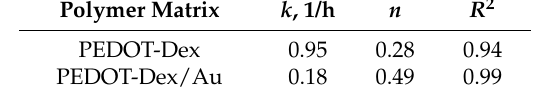
Figure 4. Dex release from Dex-doped PEDOT and PEDOT composite substrates. ( A ) Drug elution profiles of spontaneous Dex release from PEDOT-Dex and PEDOT-Dex/Au functionalized electrodes. Dots are the experimental values and lines represent the corresponding fitted curves calculated by means of Avrami’s equation. ( B ) Macroscopic images of PEDOT-Dex and PEDOT-Dex/Au functionalized electrodes after performing the elution experiment. Table 1. Release kinetic parameters calculated basing on Avrami’s equation for the spontaneous release of Dex from PEDOT-Dex and PEDOT ‐ Dex/Au.